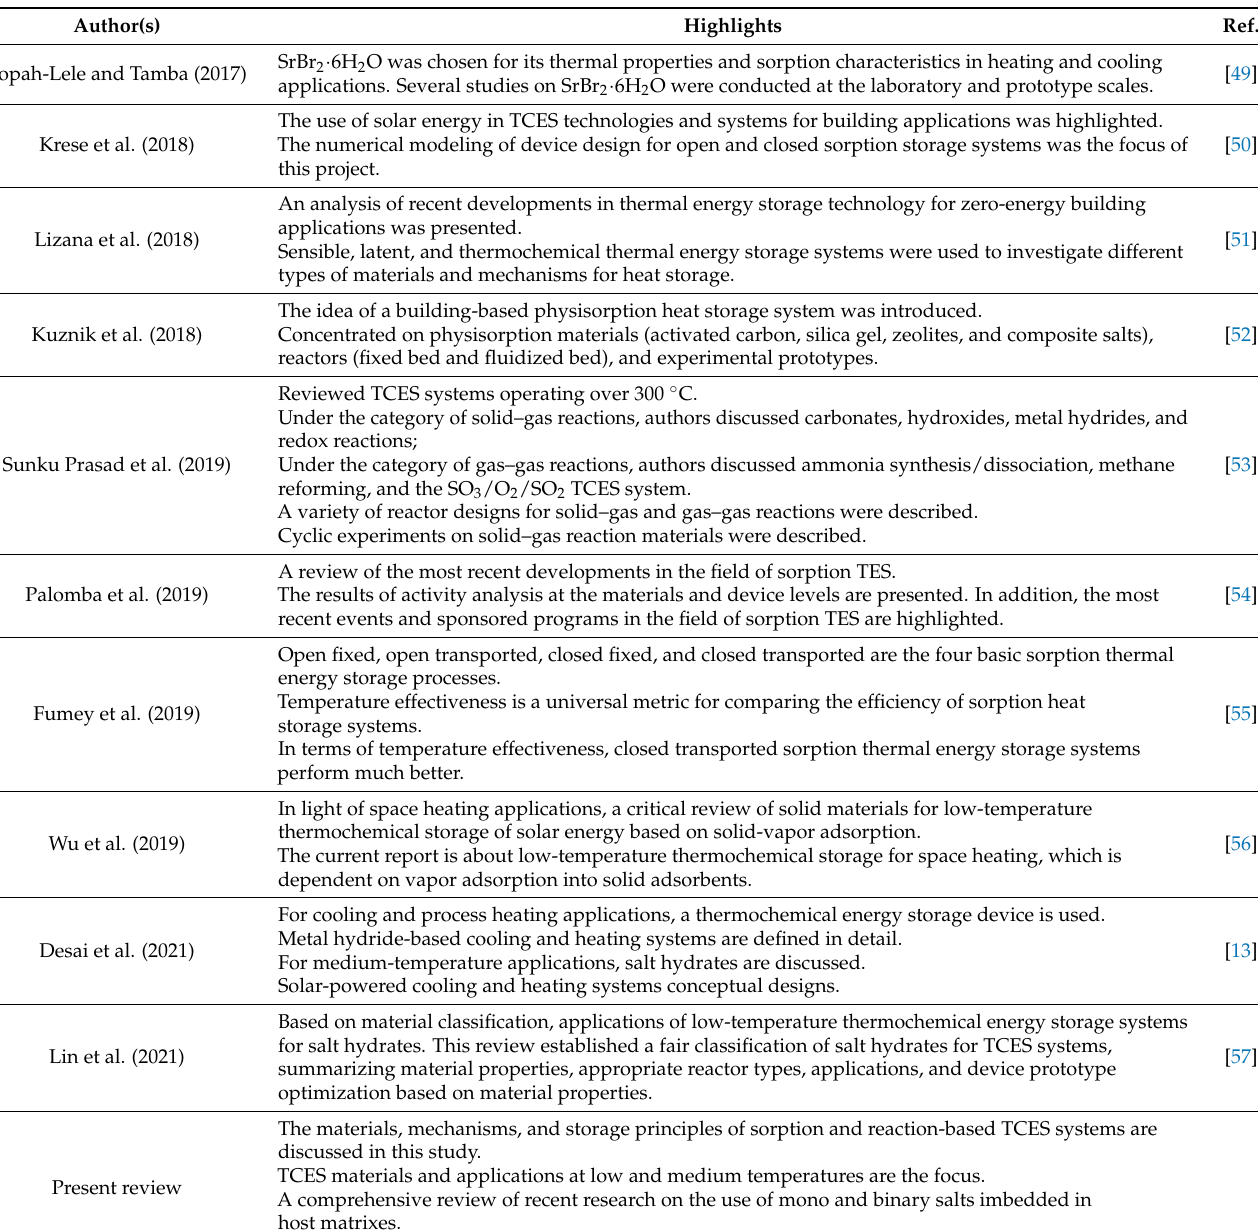
Table 2. Summary of the latest review papers on low and medium temperature TCES